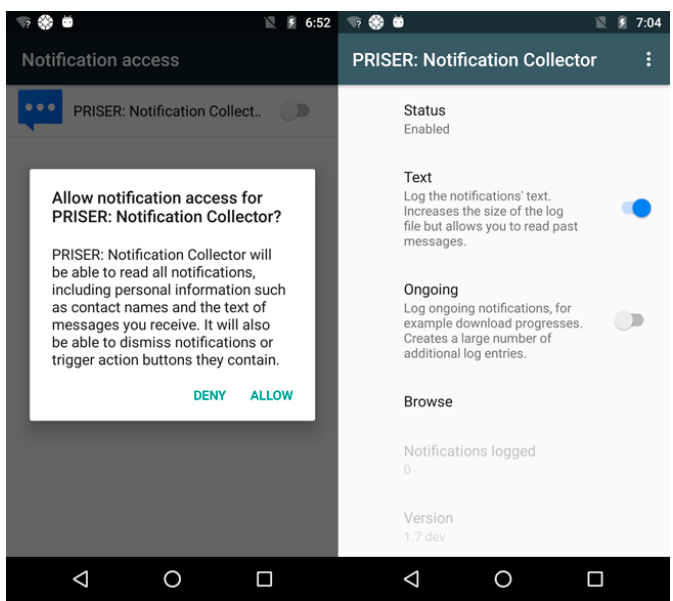
Figure 3. Notification Log Application on Android.